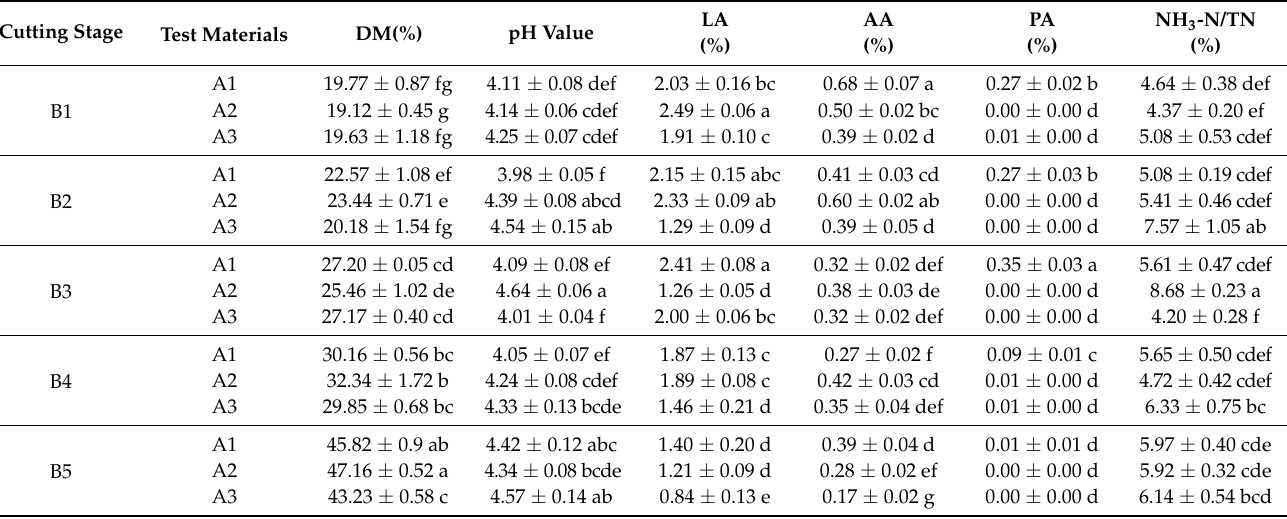
Table 3. Differences in the average silage fermentation quality for the interaction of forage species and cutting